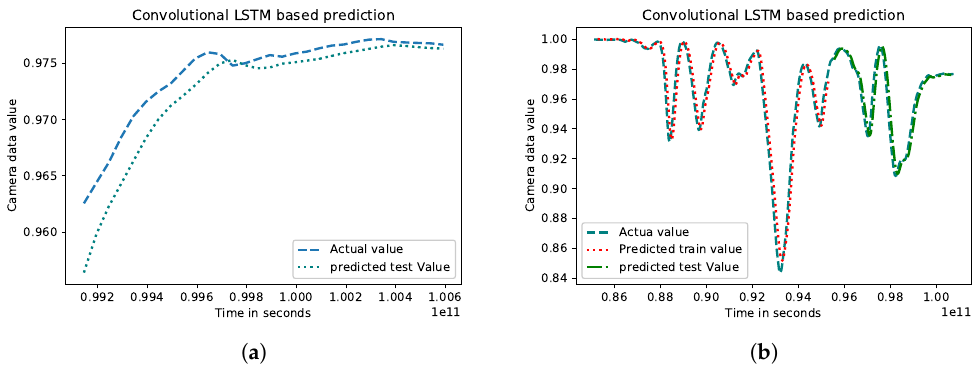
Figure 8. Bidirectional LSTM prediction output for the ( a ) 30 data points and ( b ) all data points from the data set.